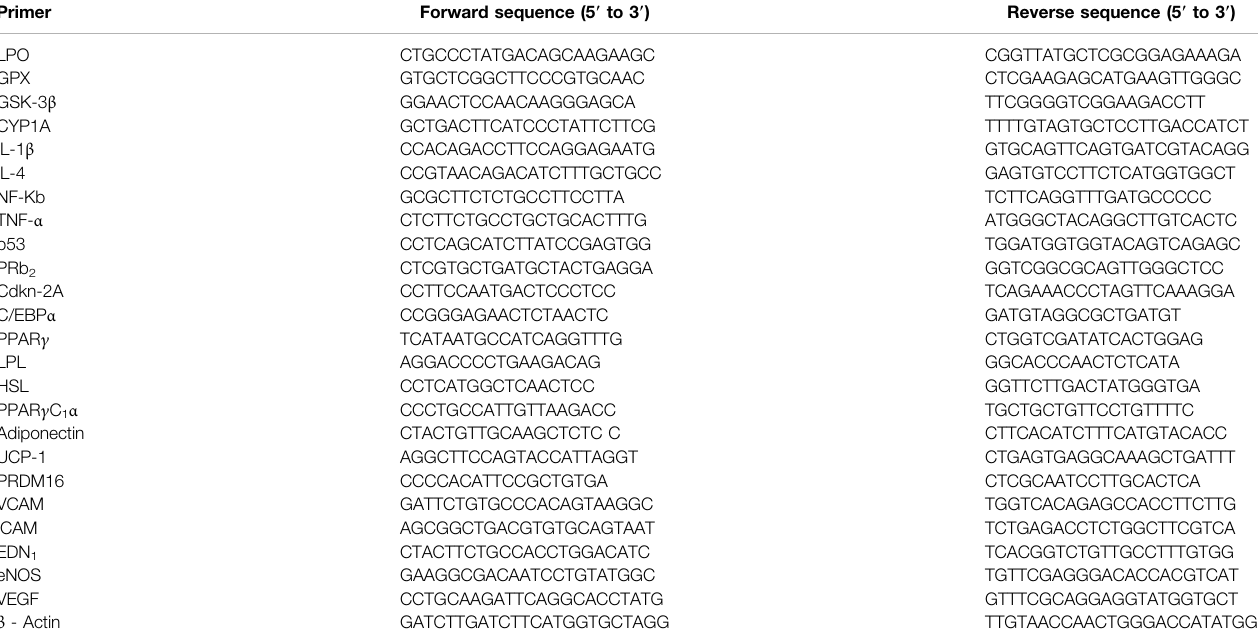
TABLE 1 | Primers sequences used in the sybrgreen based real-time polymerase chain reaction (RT-PCR). Primer Forward sequence (5 9 to 3 9